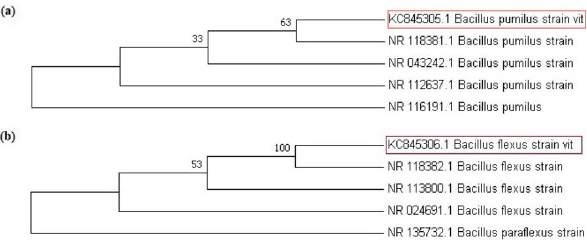
Figure 2. Phylogenetic tree for (a) Bacillus pumilus and (b) Bacillus flexus